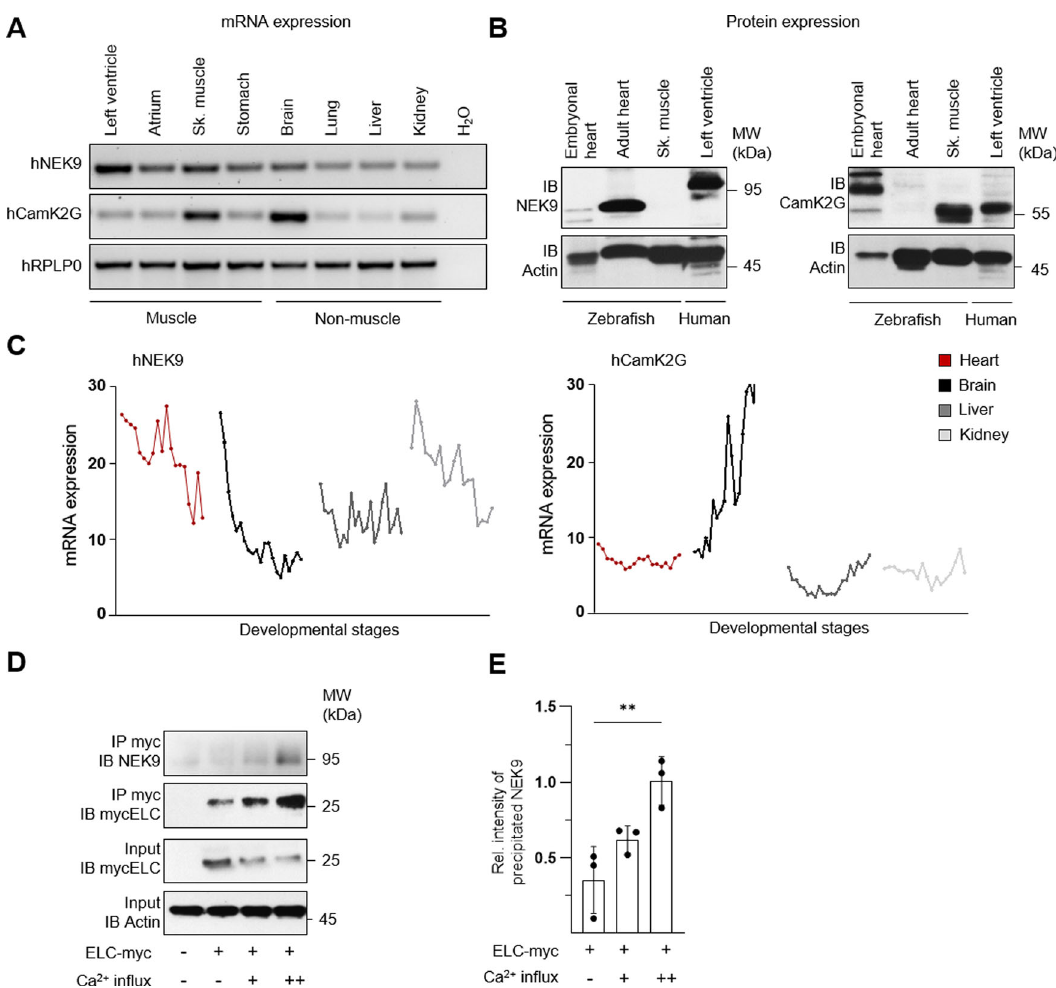
Fig. 2 | Characterization of ELC interacting kinases. A NEK9 and CamK2G RNA expression in human total RNA tissue panel. Ribosomal protein large subunit P0 (RPLP0) was used as housekeeping gene. B NEK9 (left panel) and CamK2G (right panel)proteinexpressioninpiscineandhumanhearttissuetodetectcross-species applicability. C mRNA expression pro fi le of NEK9 and CamK2G in different human tissues from 4 weeks post-conception to adulthood 68 . D , E Relationship of NEK9- ELC binding ef fi ciency on intracellular Ca 2+ -concentration. NEK9-ELC interaction